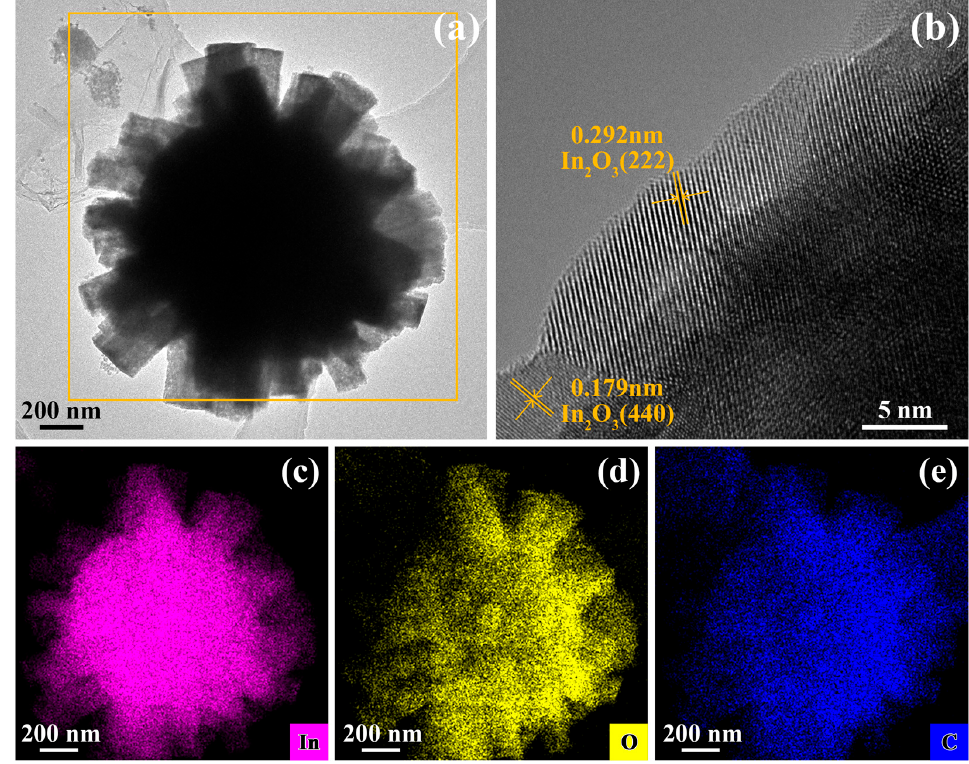
Figure 4. ( a ) TEM image, ( b ) high-resolution TEM image, and ( c – e ) its corresponding elemental mapping of 5-rGO/In 2 O 3 composites.